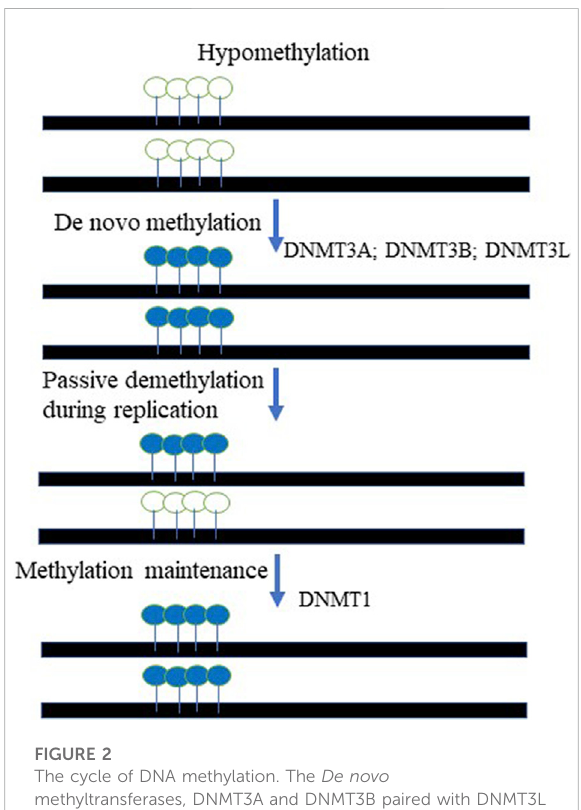
FIGURE 2 The cycle of DNA methylation. The De novo methyltransferases, DNMT3A and DNMT3B paired with DNMT3L chaperon activity methylate unmethylated DNA templates at the CpG context. The maintenance mechanism ensures that hemi-methylatedtemplatedcreated duringDNAreplication areto be fully methylated on both DNA strands. DNMT1- DNA maintenance methyltransferase is responsible for that activity. Open lollipops represent unmethylated DNA, while painted lollipops represent the DNA that